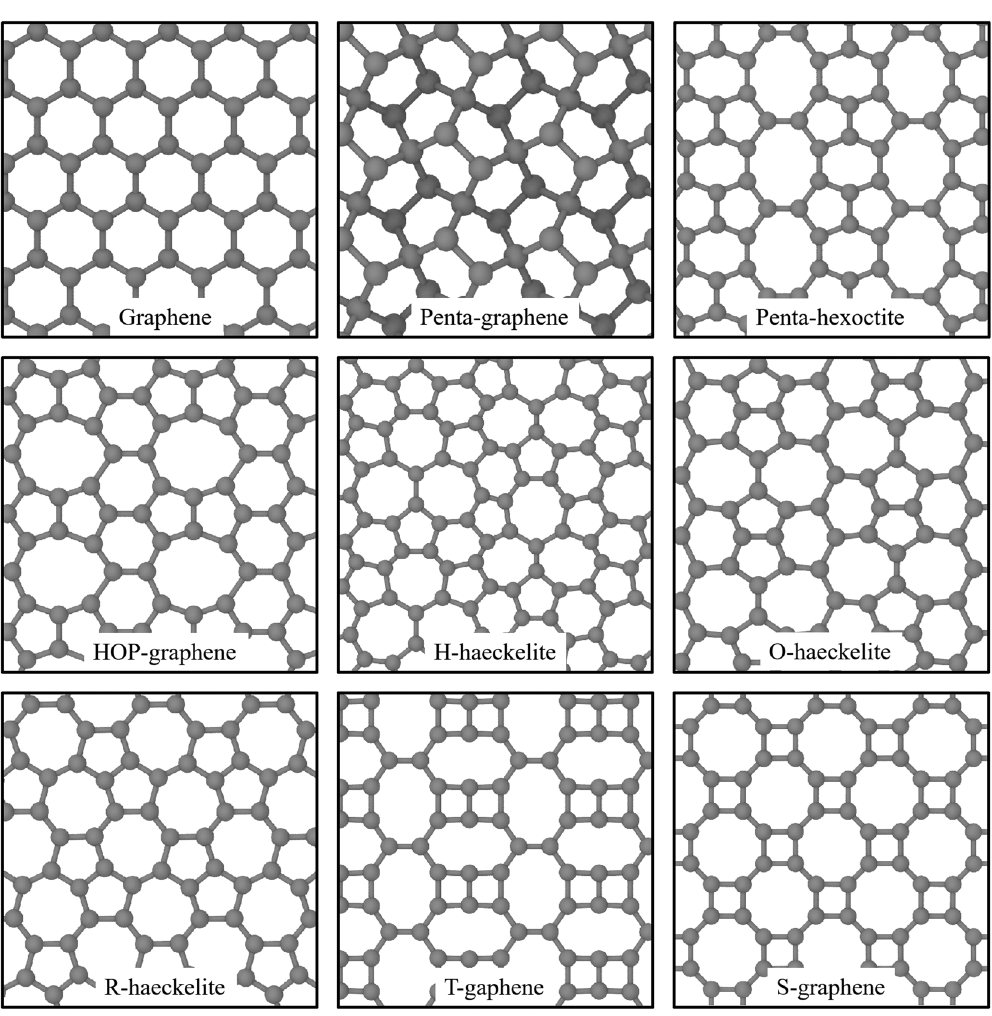
Figure 1: Top views of atomic models of graphene, penta - graphene, penta - hexoctite, HOP - graphene, H - haeckelite, O - haeckelite, R - haeckelite, T - graphene, and S -